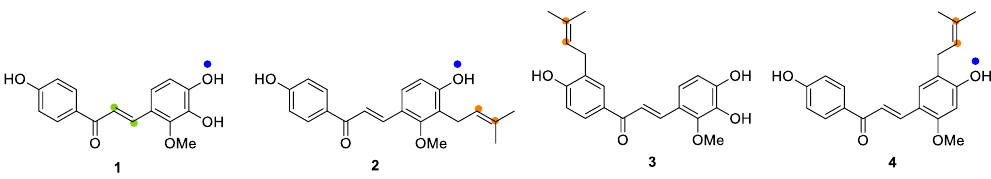
Figure 2. Possible metabolic points of licochalcones B ( 1 ), C ( 2 ), D ( 3 ) and H ( 4 ) by A. niger and M. hiemalis , with saturation of the double bond in case of hydrogenation (green), dihydroxylation and epoxidation (orange), and glycosylation (blue).